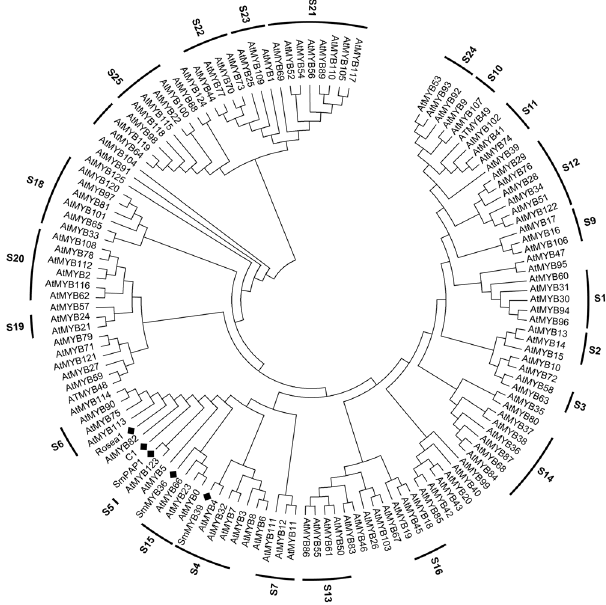
Figure 2. The phylogenetic tree of R2R3-MYB transcription factors. The phylogenetic tree was constructed by maximum likelihood method of MEGA 6.06 based on the multiple sequence alignment using MUSCLE